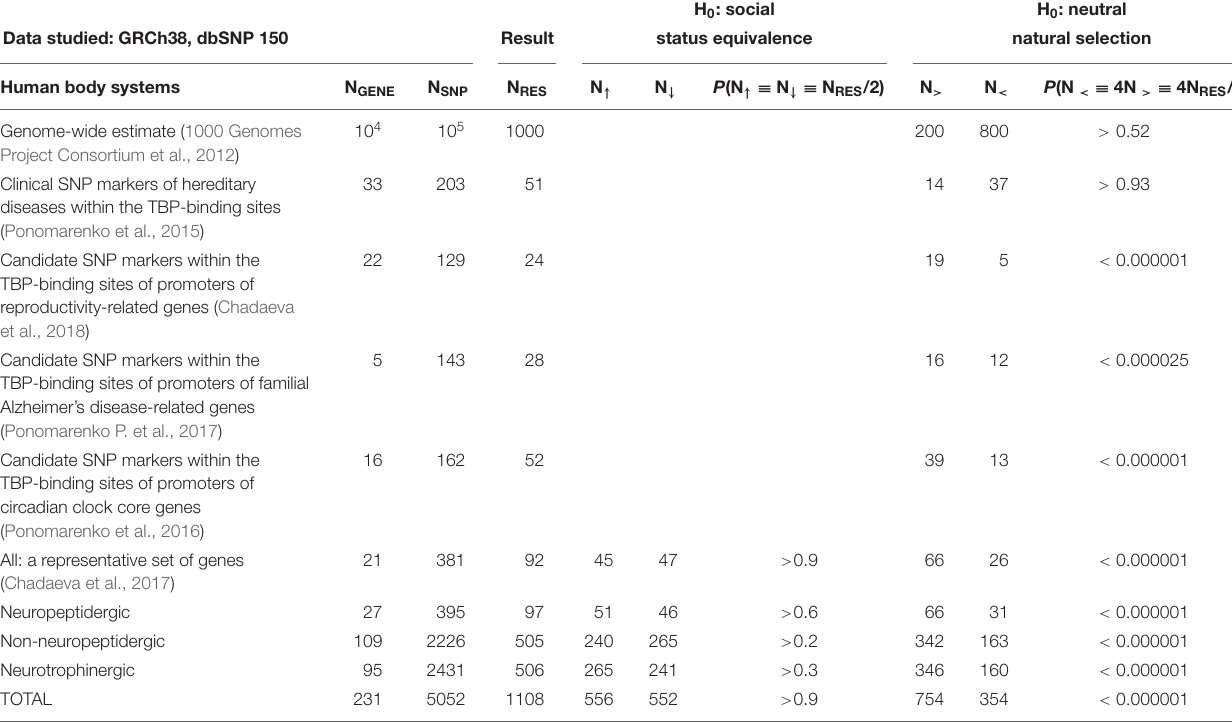
TABLE 2 | Predictions of candidate SNP markers that can statistically significantly alter the TATA-binding protein (TBP)-binding sites of the human gene promoters of all the protein-coding transcripts relating to neuropeptidergic, non-neuropeptidergic, and neurotrophinergic systems. H 0 :